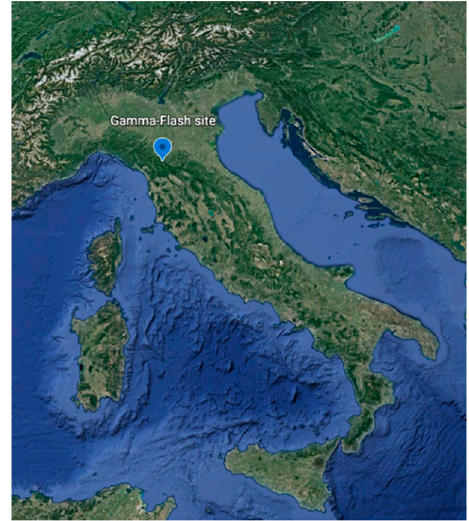
Figure 1. The Gamma-Flash site located at the Italian Climate Observatory “O. Vittori” on the top of Mt. Cimone (44, 17N, 10, 68E, 2165 m a.s.l.—Northern Italian Apennines).